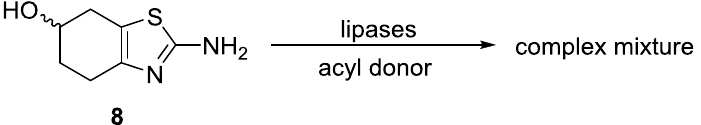
Scheme 3. First attempt of enzyme-catalyzed resolution of compound 8 .